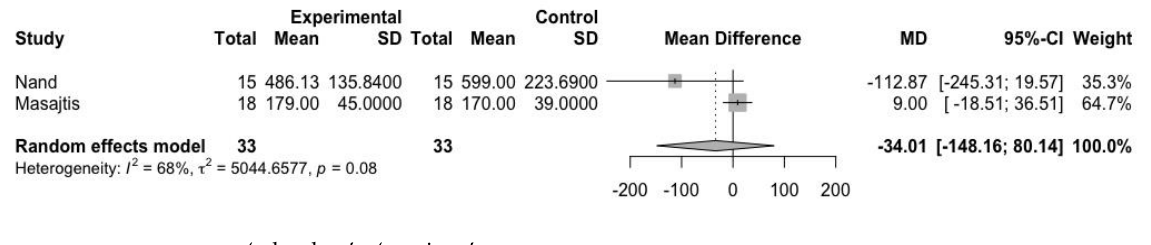
Figure 9. Mean difference of ferritin between experimental group and control group at baseline.